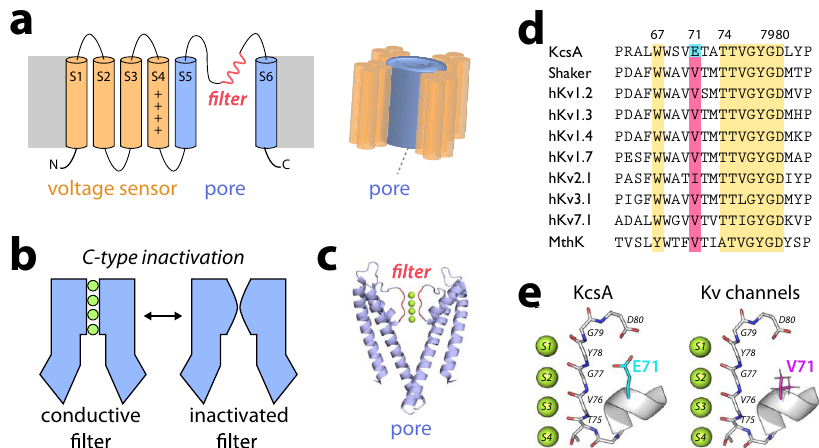
Fig. 1 C-type inactivation and selectivity fi lter gating. a Topology diagram of voltage-gated K + (Kv) channels. Helices S1-S4 form the voltage-sensor, while helices S5-S6 form the pore comprising the selectivity fi lter. b Slow C-type inactivation renders the selectivity fi lter of K + channels non-conductive. c The bacterial KcsA channel is a model for the pore of Kv channels. d , e The selectivity fi lter (T74-G79 in KcsA) and residues W67, D80 are conserved while the residue corresponding to E71 in KcsA is substituted by a valine in Kv